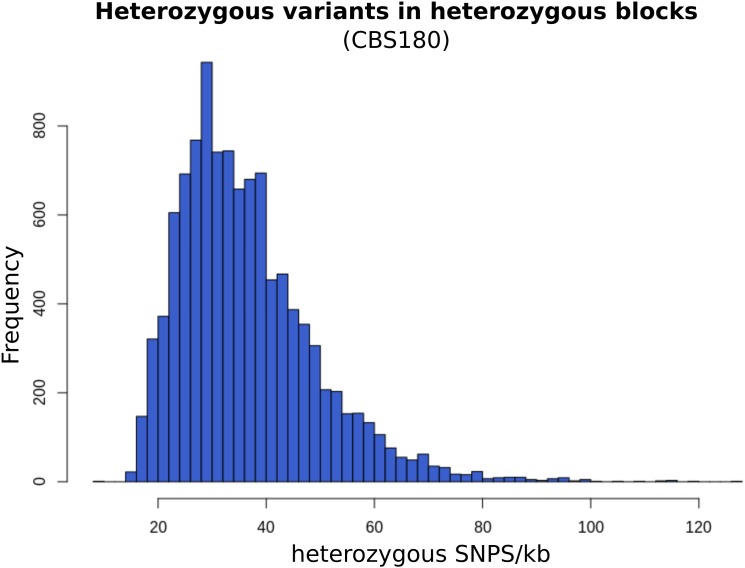
Frequency of heterozygous variants per kilo-base in CBS180 heterozygous blocks. The distribution of this frequency is close to normal, with a peak at 30 variants/kb, consistently with the estimated current parental divergence.